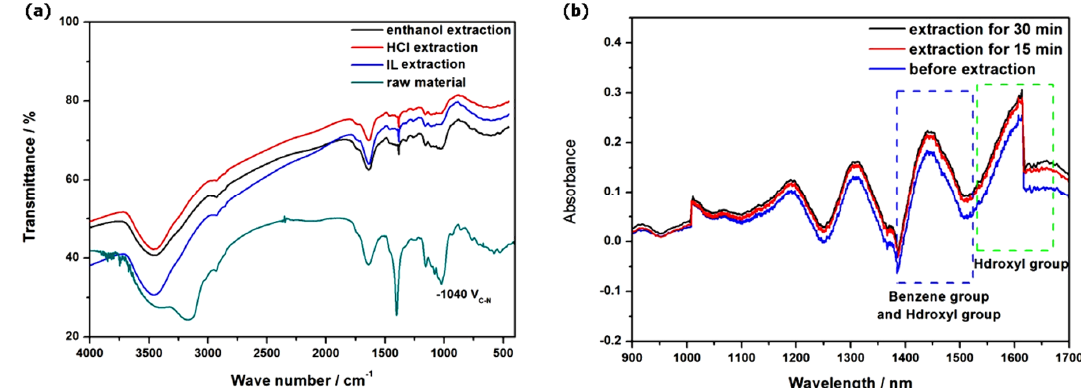
Figure 6. Comparison on IR spectra (KBr disc) of herbal residue before and after extraction by different solvents ( a ) and NIR detection on different time points during IL extraction ( b ).